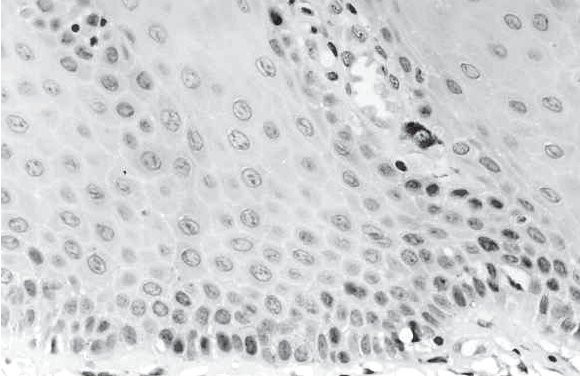
FIGURE 1- Leukoplakia degree I. p53-positive cells in basal and parabasal layers (original magnification: TABLE 2- p53-positive cells score (Area: 19,500 µm.